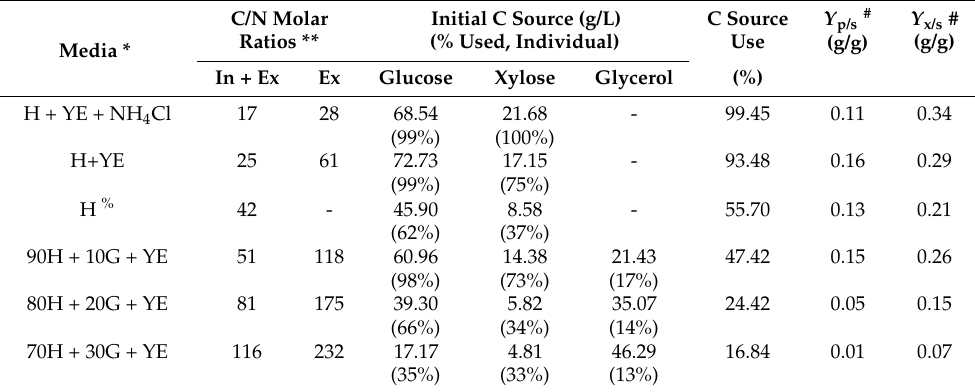
Table 5. Carbon source use, lipid yield and cell yield when cultivating R. glutinis TISTR 5159 for a maximum of 10 days in the bagasse hydrolysate with C/N molar ratio adjusted by adding yeast extract and NH 4 Cl or glycerol.